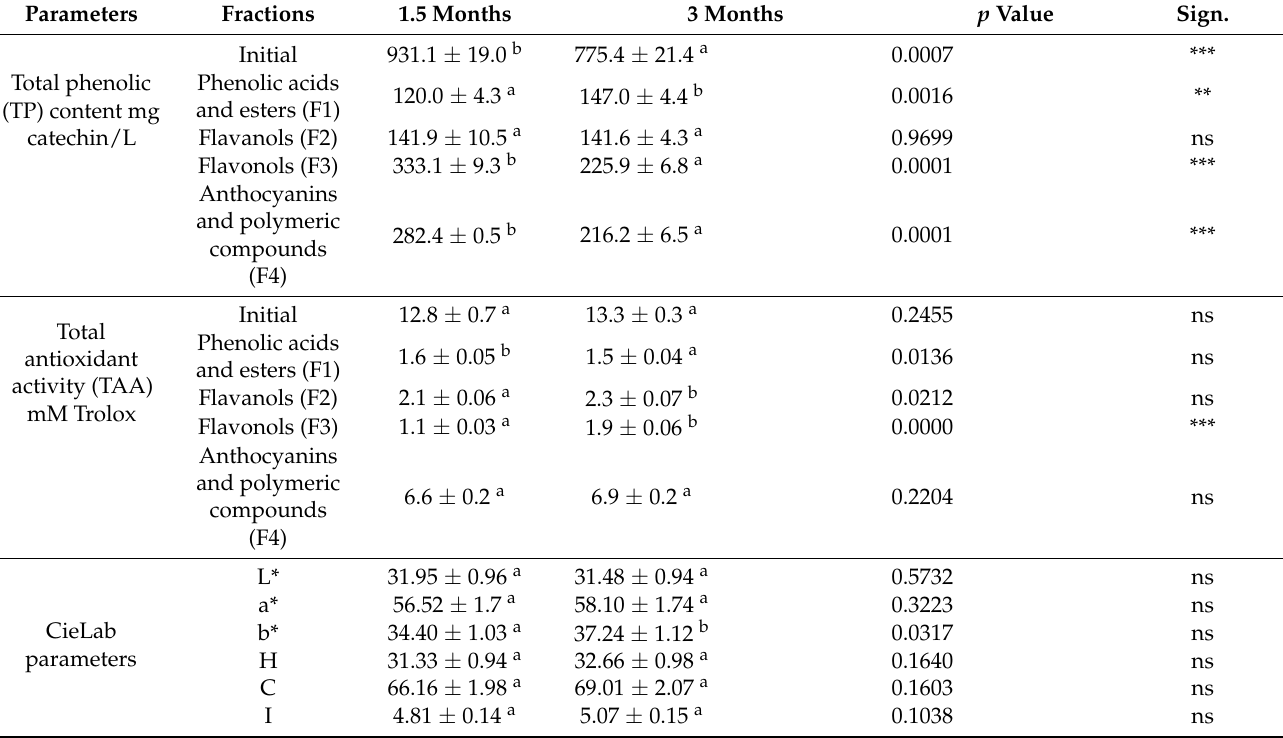
Table 1. Chemical parameters of red wines aged with oak staves for 1.5 and 3 months.